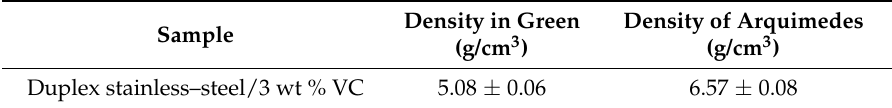
Table 1. Values of green density, sintered material density and Archimedes density of stainless–steel with the addition of 3% VC.